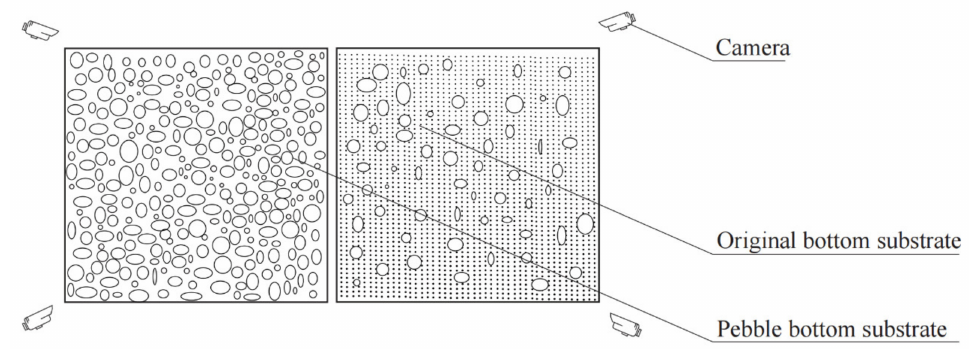
Figure 4. The field riverbed substrate transformation